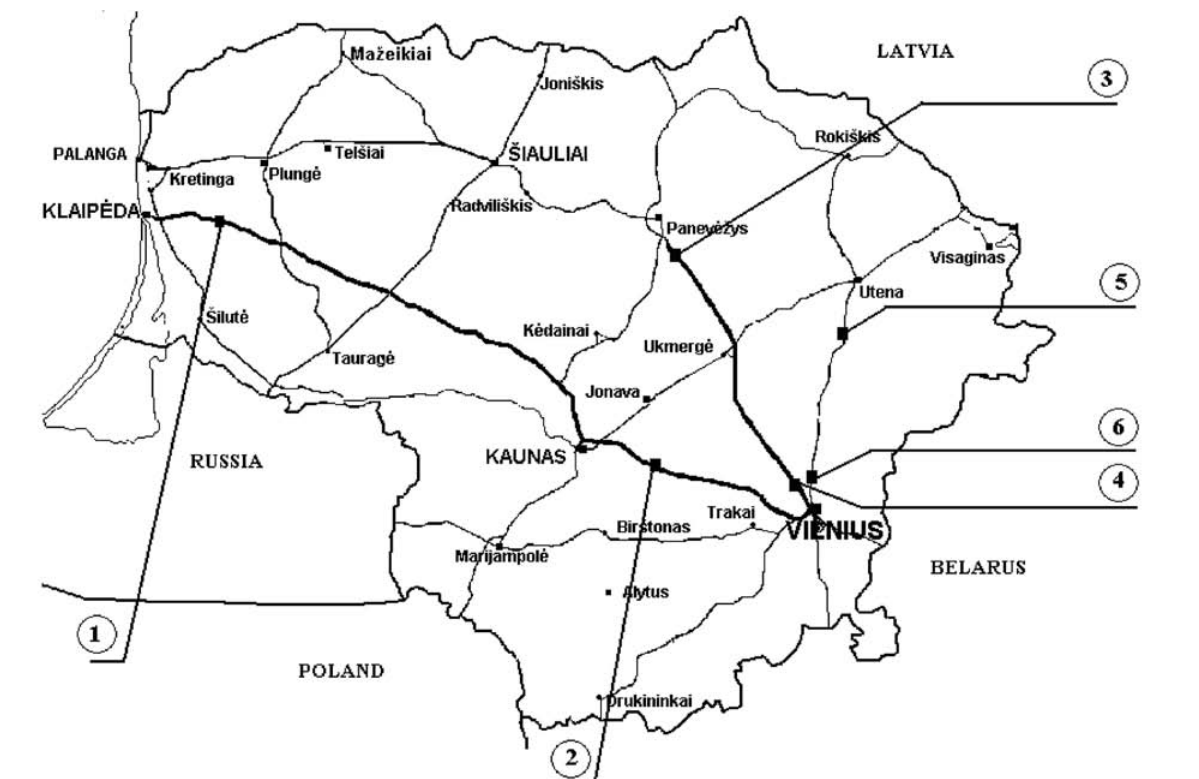
Fig. 3. Measurement locations in the map of Lithuania: 1 – Vilnius–Klaipėda, 283 rd km; 2 – Vilnius–Kaunas, 65 th km; 3 – Vilnius– Panevėžys, 122 nd km; 4 – Vilnius–Panevėžys, 12 th km; 5 – Utena–Vilnius, 11 th km; 6 – Utena–Vilnius, 84 th km